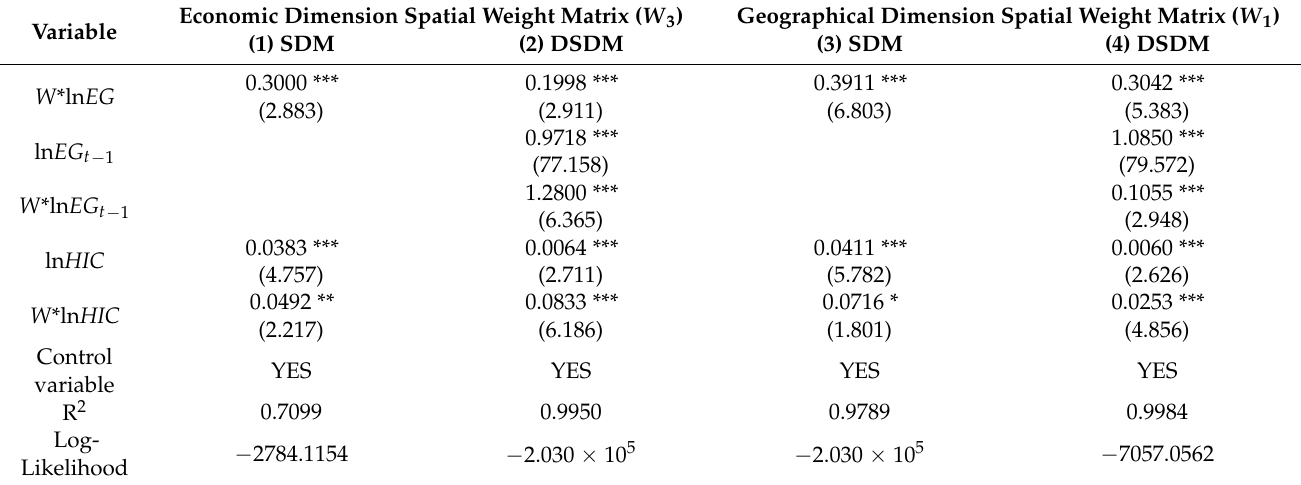
Table 8. Robustness test results of the impact of hydropower on regional economic growth. Economic Dimension Spatial Weight Matrix ( W 3 Variable